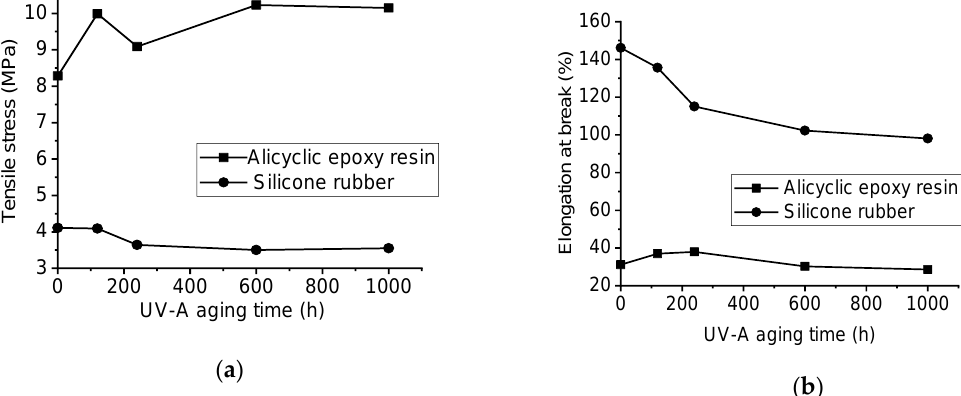
Figure 7. Comparison of mechanical properties of two samples at different UV-A aging time: ( a ) tensile stress; ( b ) elongation at break.